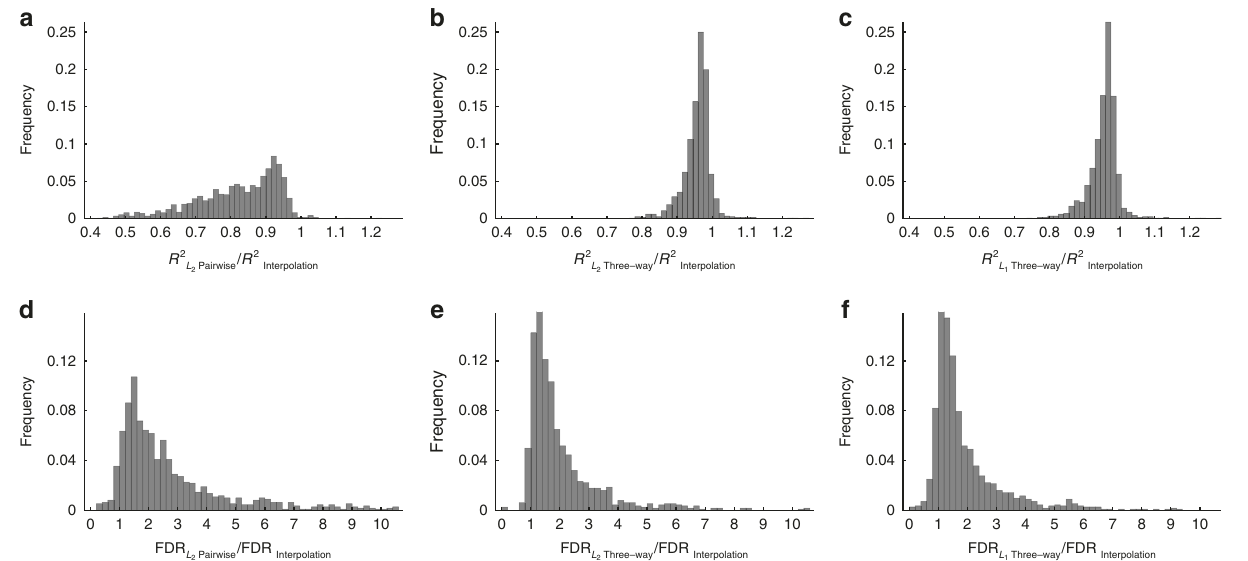
Fig. 6 Model comparison using protein-binding microarray data from 1121 transcription factors 48 . For each TF, 80% of sequences were randomly assigned as training data. L 2 -regularized pairwise regression, L 2 -regularized three-way regression, and L 1 -regularized three-way regression were fi t with regularization parameter chosen by cross-validation. For each TF, we calculate the out-of-sample R 2 and false discovery rate (FDR) de fi ned as the frequency that an out-of-sample genotype predicted to be above the 95th percentile of the data were in fact below the 95th percentile. a – c Histograms of the ratios of R 2 of the regression models and minimum epistasis interpolation. d – f Histograms of the ratios of the false discovery rate of the regression models and minimum epistasis